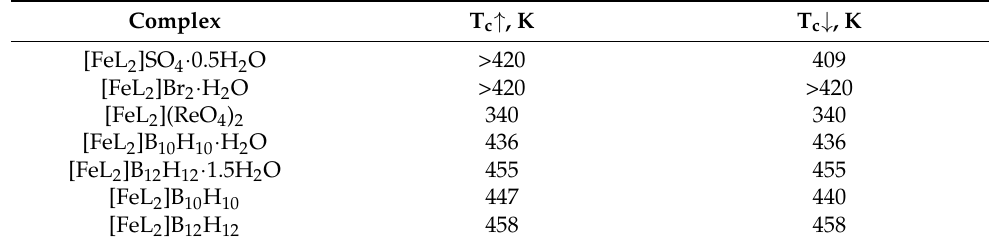
Table 6. The temperatures of direct (T c ↑ ) and inverse (T c ↓ ) SCO for the studied complexes. Complex